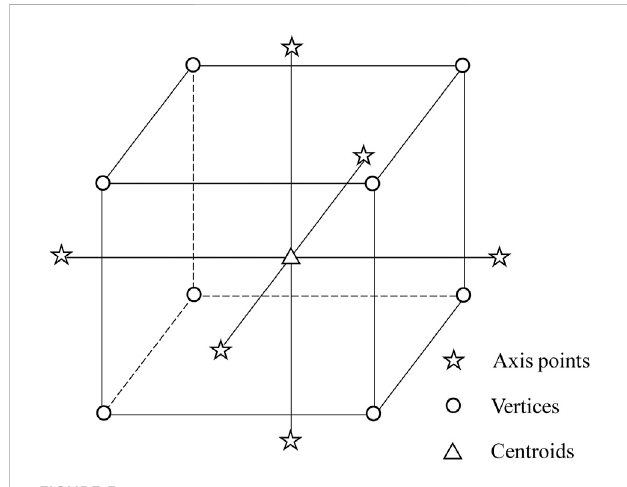
The “ cube ” experimental point of the central composite